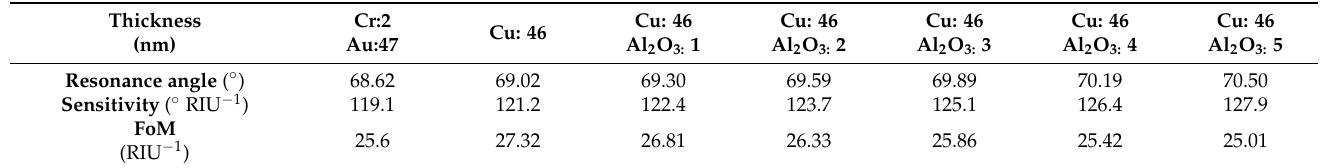
Table 1. A table presenting the resonance angle, sensitivity, and figure-of-merit for 47 nm of Au with 2 nm of Cr adhesion layer and 46 Cu surface passivated with different Al 2 O 3 thickness.